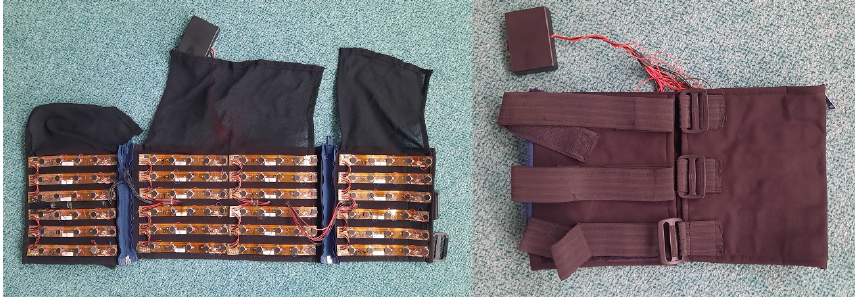
Figure 9. Vest-like feedback device with 4 × 30 vibrators